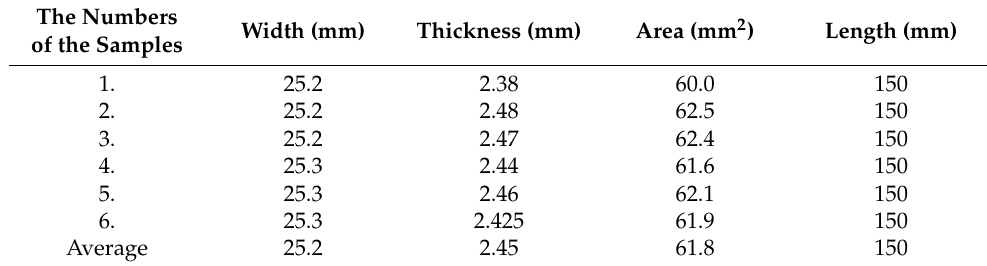
Table 9. Analysis of the obtained test results for a composite laminate reinforced with IMS65 mod- ular fabric, 0/90° configuration.